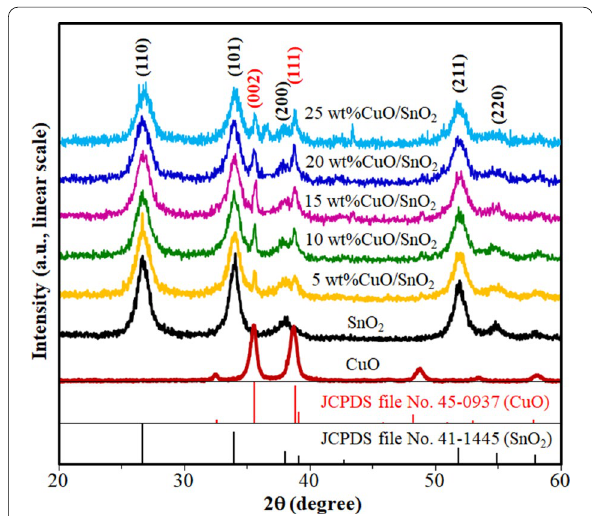
Fig. 2 XRD pattern of CuO, SnO 2 and 5–25 wt% CuO/SnO 2 NPs